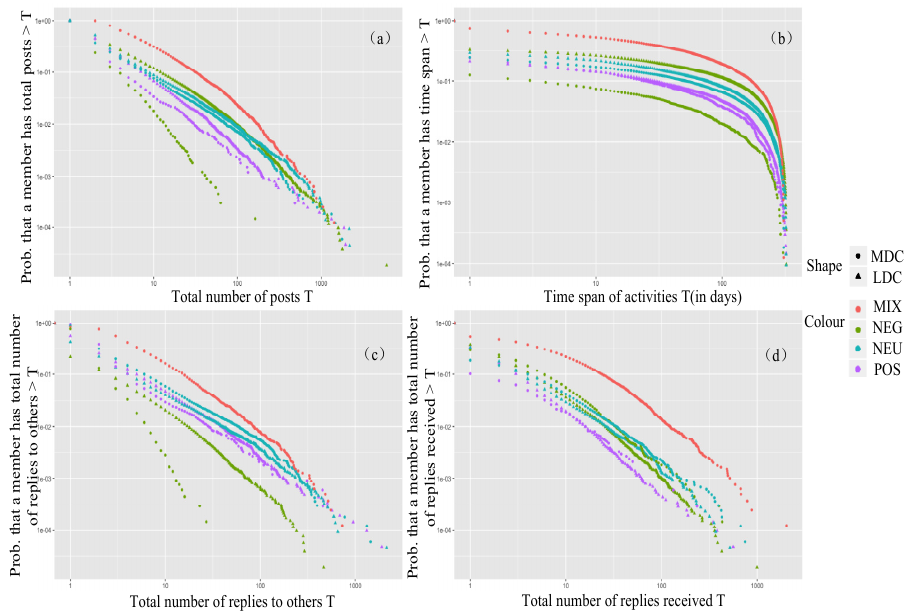
Figure 4. Complementary cumulative distributions of engagement metrics for the different clusters of emotion expression: ( a ) productivity, ( b ) loyalty, ( c ) social activity, and ( d ) attention received.